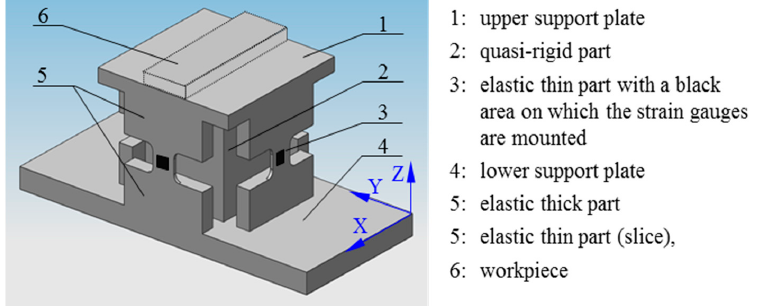
Figure 2. Schematic diagram of the main structure.